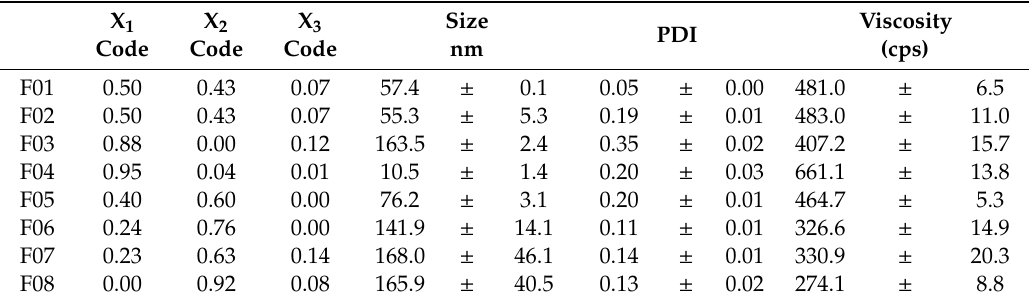
Table 1. The composition and physicochemical properties of model gemcitabine-loaded formulations provided mixture